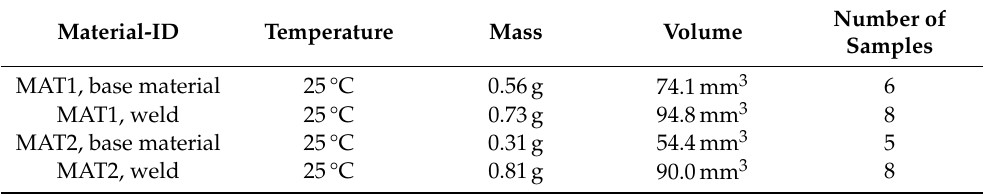
Table 5. Individual geometries of the samples for the